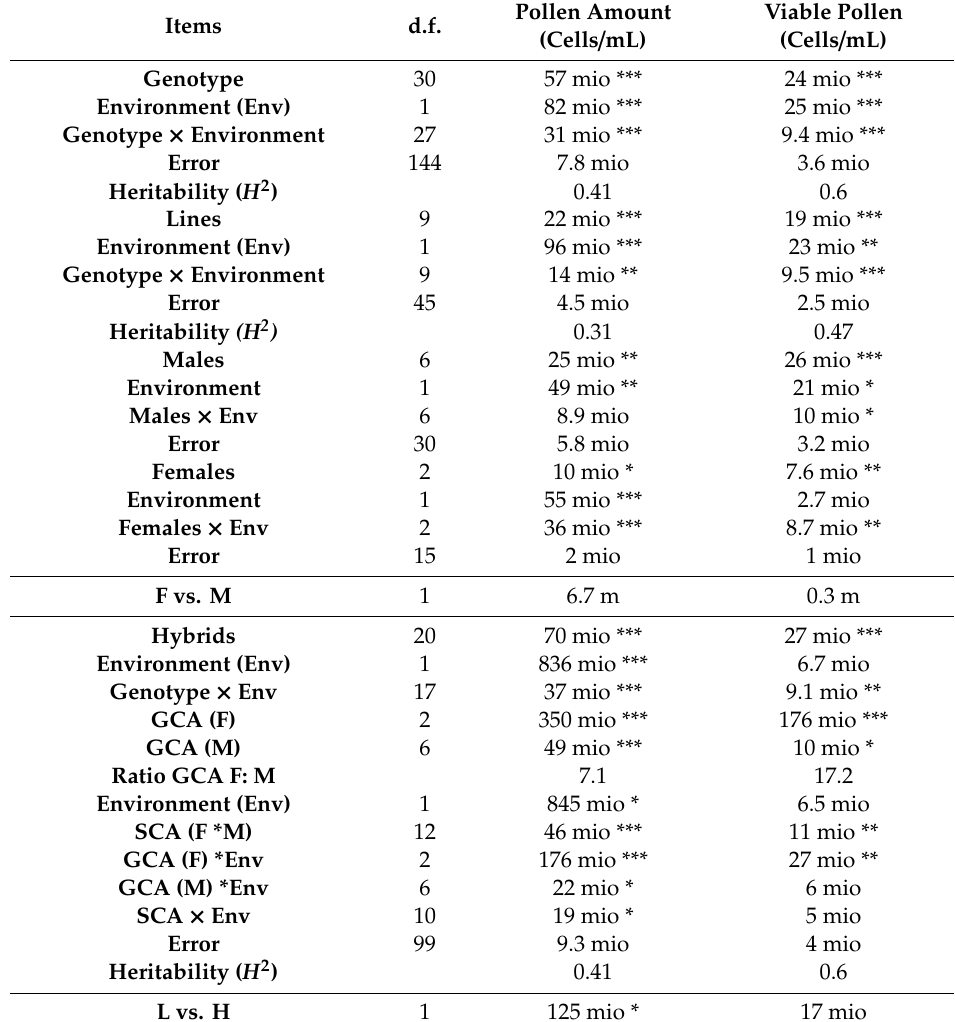
Table 5. Genotypic variances (mean squares) and their interactions for the traits pollen amount (cells / mL) and viable pollen number (cells / mL) across the environments of Gross-Gerau and